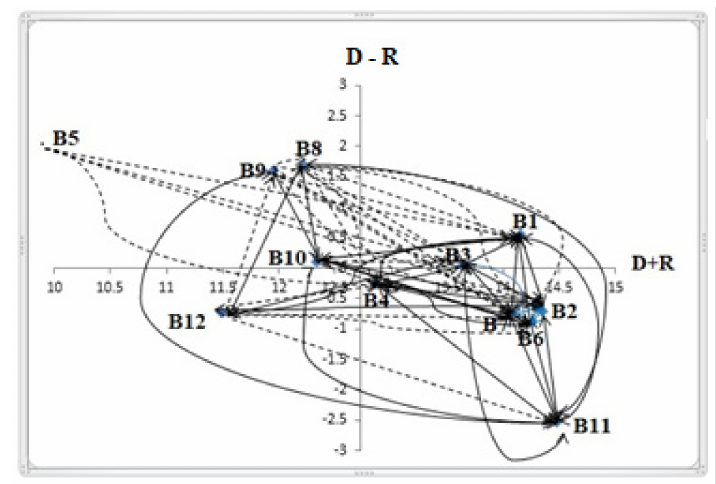
Figure 5. Causal inter relationships of CE obstacles.